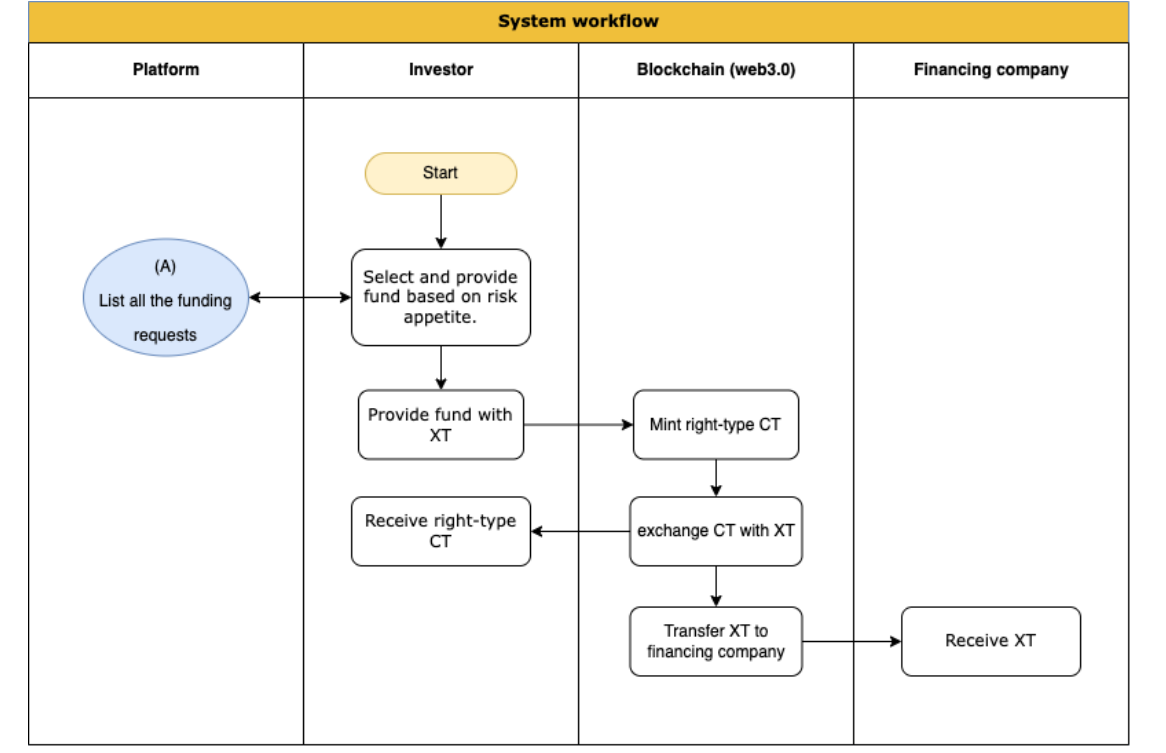
Figure 11. The workflow of providing fund, where (A) is the list of funding requests described in Figure 10.